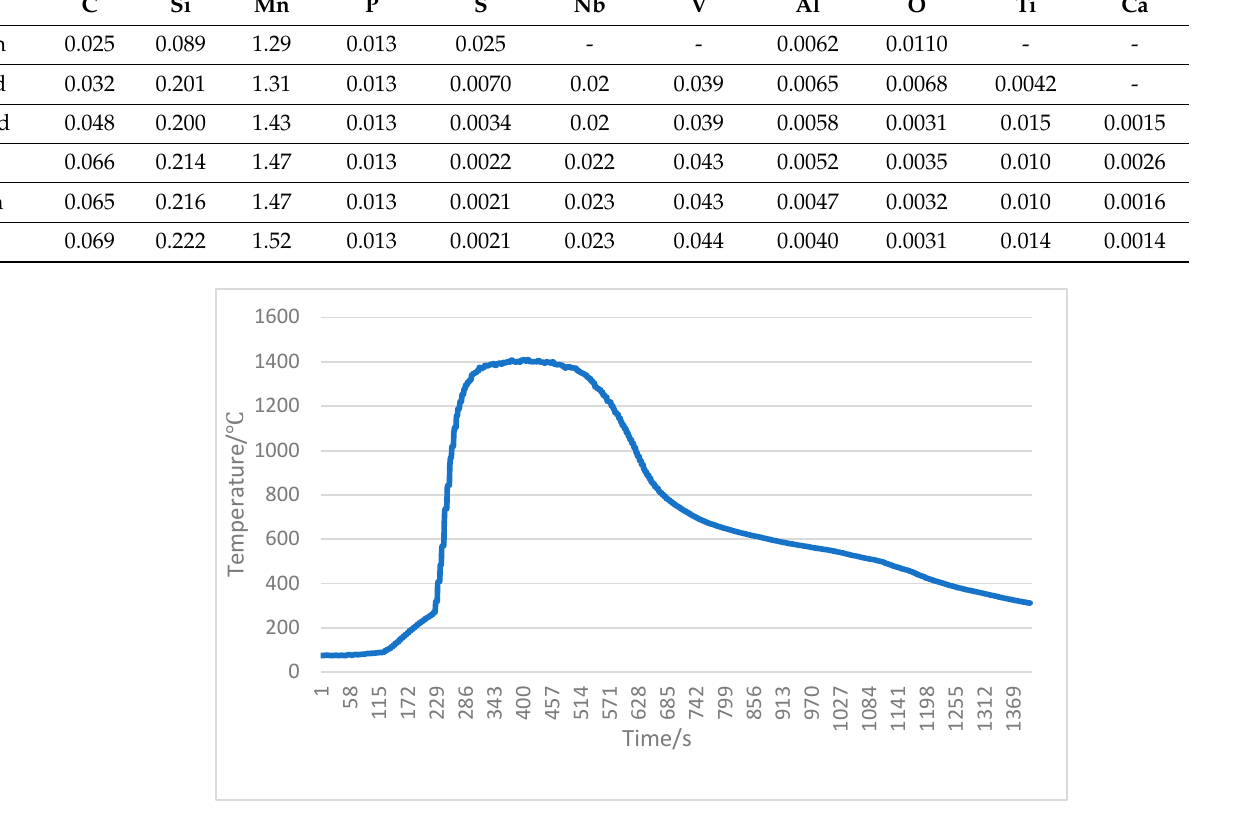
Figure 1. The measured temperature curve of welding thermal simulation.